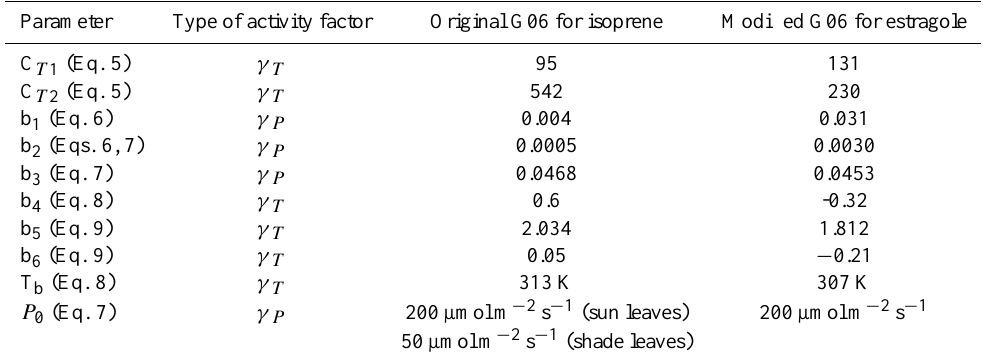
Table 3. Comparison of empirical constants between G06 for isoprene and modified G06 for